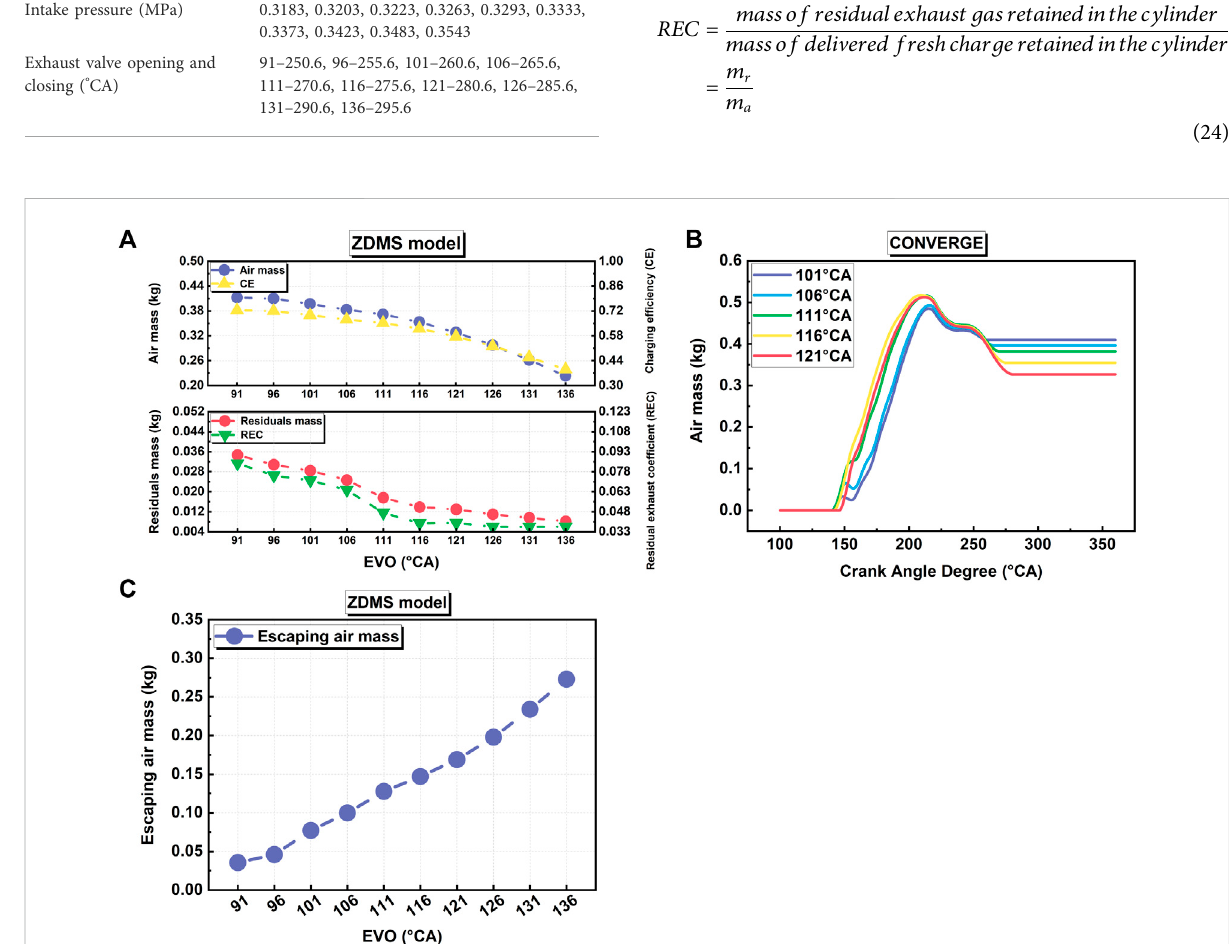
FIGURE 8 (A,B) Air mass, CE, residuals mass, REC, and (C) escaping air mass at 75% load with different intake